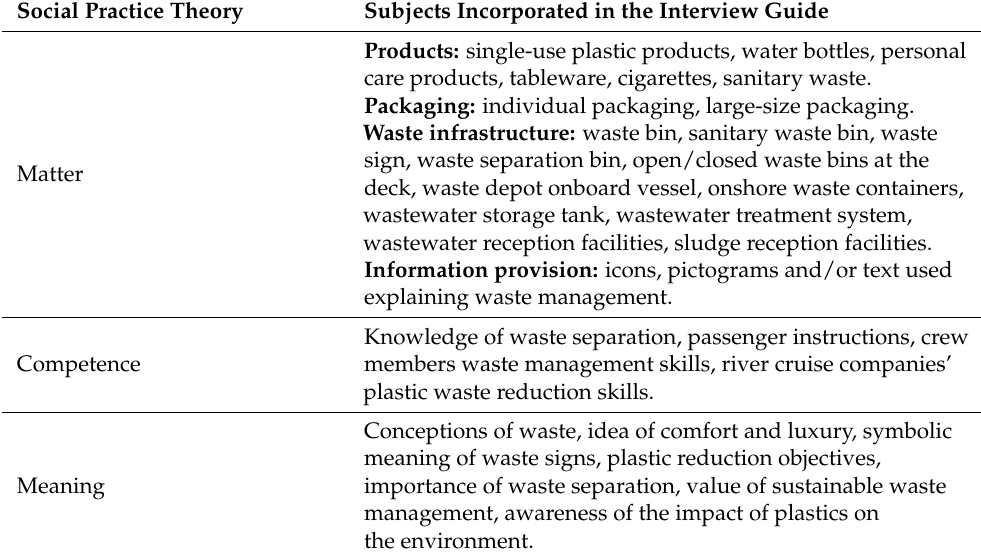
Table 2. Elements of the Social Practice Theory of Shove et al. [17] linked to river cruise companies’ practices related to plastics as incorporated in the interview